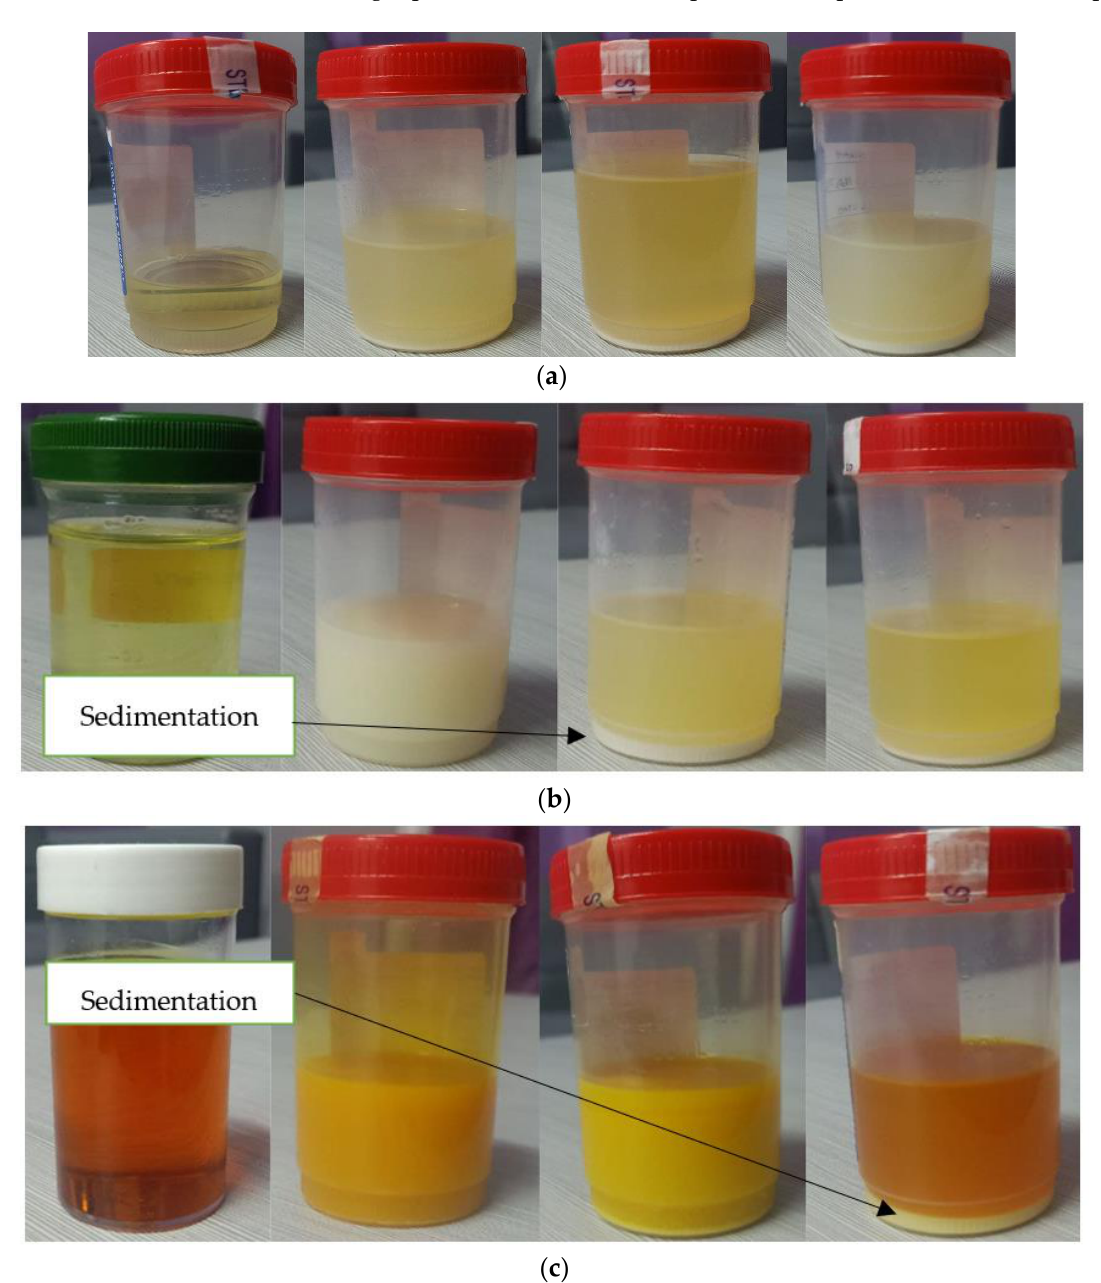
Figure 2. Condition of vegetable oil hybrid nanofluids after 30 days: ( a ) coconut oil, ( b ) soybean oil, and ( c ) palm oil.